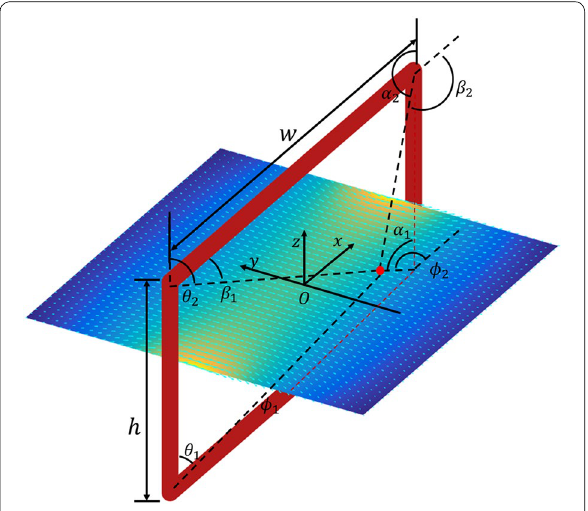
Figure 2 Single current-carrying rectangle-shaped